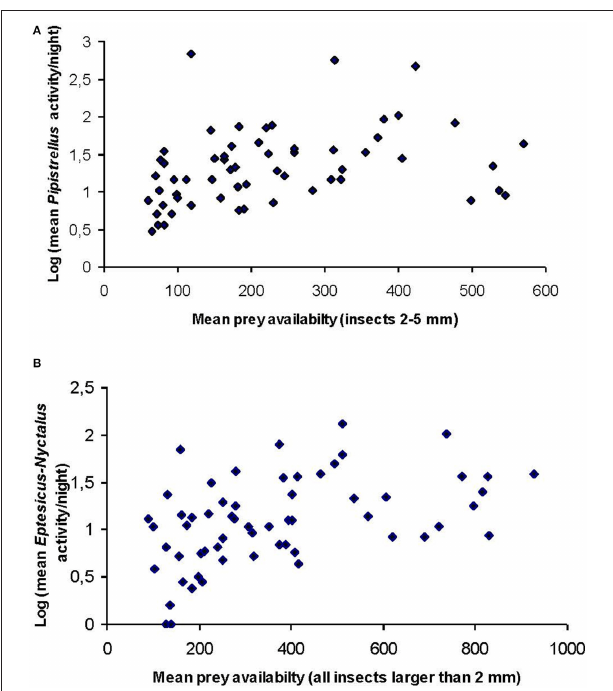
FIGURE 1 | Scatter plots of site-specific mean ( n = 5 nights per site) bat activity of (A) Pipistrellus and (B) Eptesicus-Nyctalus against site-specific availability of the corresponding prey groups. Data were log transformed to account for the high variability at sites and sampling